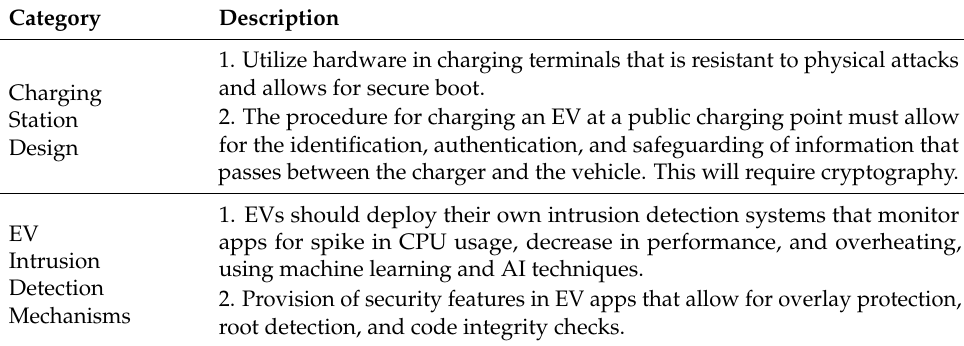
Table 3. Defensive